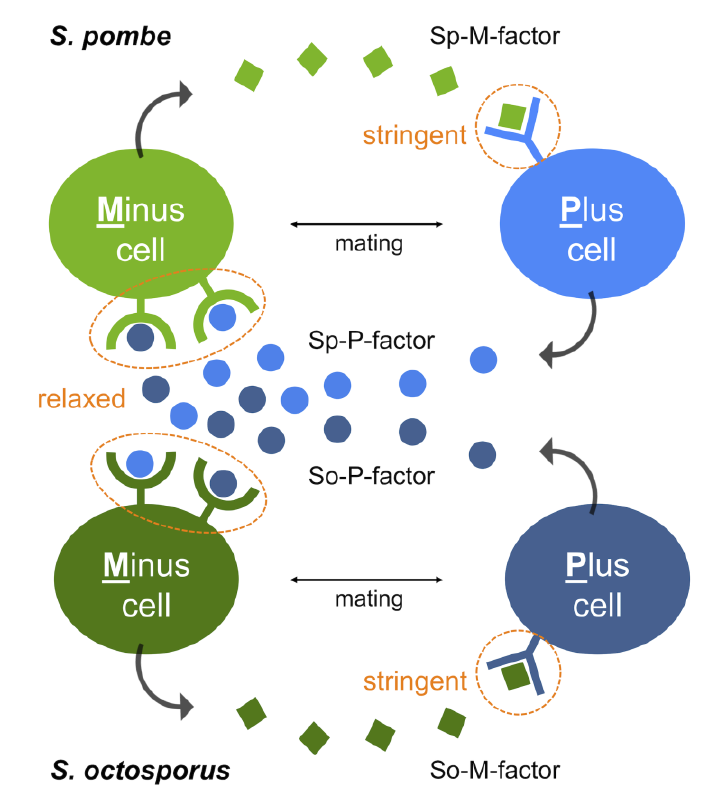
FIGURE 1: M-factor function is stringent, whereas P- factor function is more relaxed, extending beyond species. M-factor and P-factor, secreted by M inus and P lus cells, respectively, are recognized by their corre- sponding receptor on the surface of cells of the oppo- site mating type. Whereas the specificity of M-factor recognition is extremely stringent, that of P-factor recognition is more relaxed, allowing cross-reactions to occur even between S. pombe and S. octosporus . P- factor is interchangeable between the two species, but not M-factor. Sp, S. pombe ; So, S. octosporus